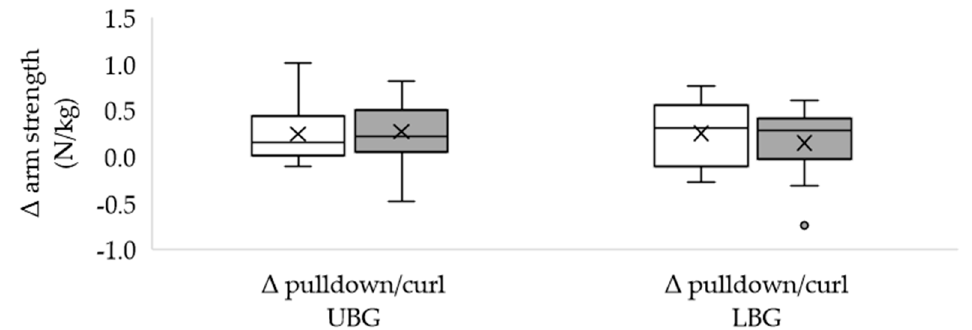
Figure 3. Differences between the final and the initial body weight adjusted maximum arm strength (biceps curl and triceps pulldown) in the upper body group and in the lower body group. ∆ : differ- ences; UBG ( n = 15): upper body group; LBG ( n = 13): lower body group; white box: triceps pulldown; grey box: biceps curl; the circle represents a discordant value; means are displayed by crosses and medians by crossbars; no significant differences occurred.